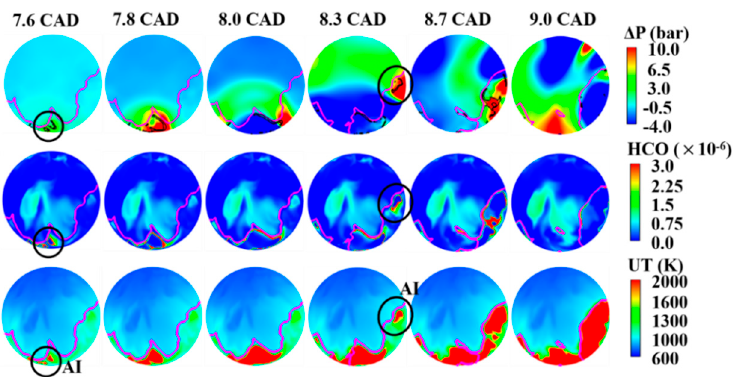
Figure 20. Evolution of Δ P, mass fraction of HCO, and unburned temperature after the initial auto-ignition at u / u 0 = 1.5.